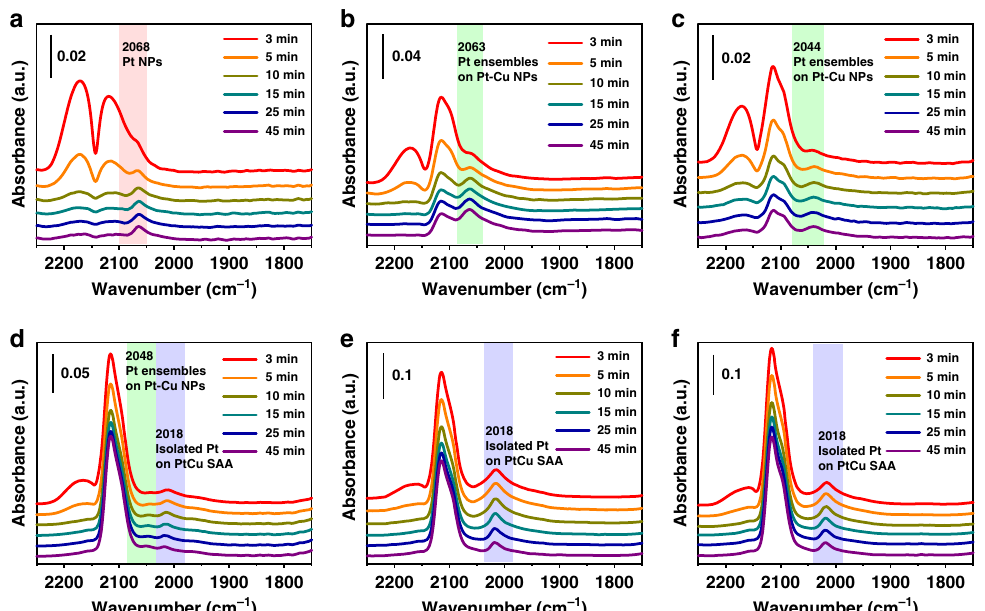
Fig. 3 In situ CO-DRIFTS for the catalysts with fi xed Pt but increasing Cu contents. a 0.1Pt/Al 2 O 3 , b 0.1Pt0.1Cu/Al 2 O 3 , c 0.1Pt0.3Cu/Al 2 O 3 , d 0.1Pt3Cu/ Al 2 O 3 , e 0.1Pt6.7Cu/Al 2 O 3 and f 0.1Pt10Cu/Al 2 O 3 . As Pt is continuously diluted with Cu, the band of CO linearly adsorbed on Pt fi rstly redshifts from